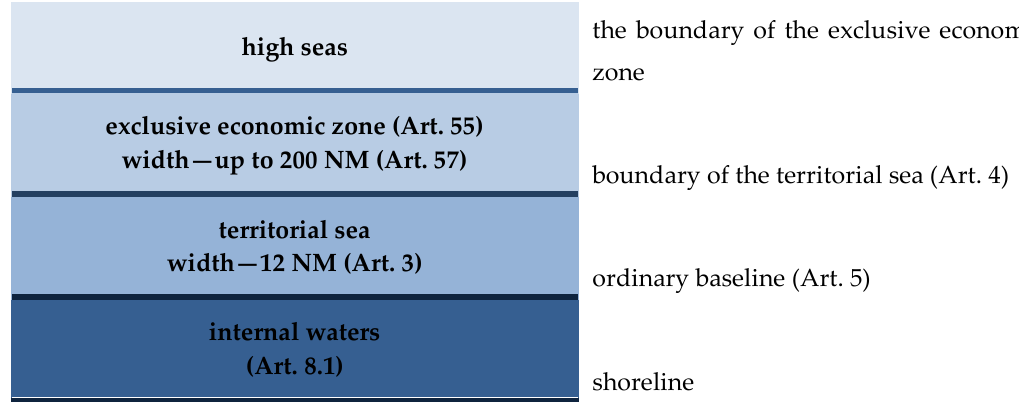
Figure 1. Maritime areas according to the UN Convention on the Law of the Sea. Source: prepared by the author.